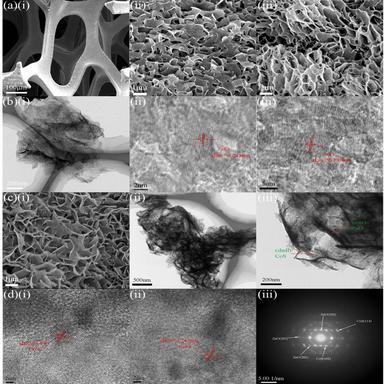
(a(i)-(iii)) SEM images of Ni foam, ZnO precursor, ZnO; b(i) TEM image of ZnO; (b(ii)-(iii)) High-resolution TEM images of ZnO; (c)(i) SEM image of ZnO@CoS; (c(ii)-(iii)) TEM images of ZnO@CoS; (d(i)-(ii)) High-resolution TEM images of ZnO@CoS; d (iii) SAED pattern of ZnO@CoS.